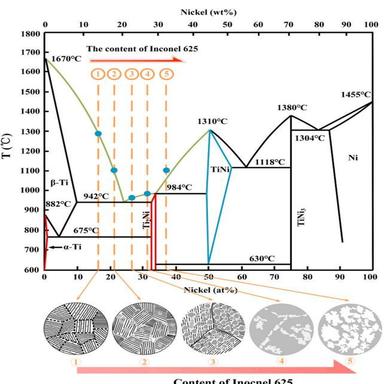
Schematic diagram of graded material and tissue growth.